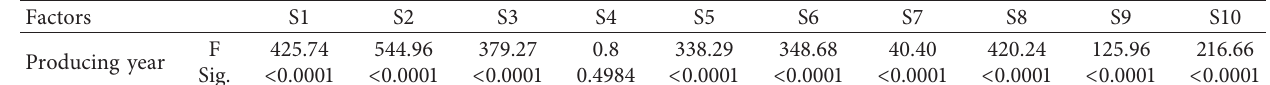
Table 3: Results of